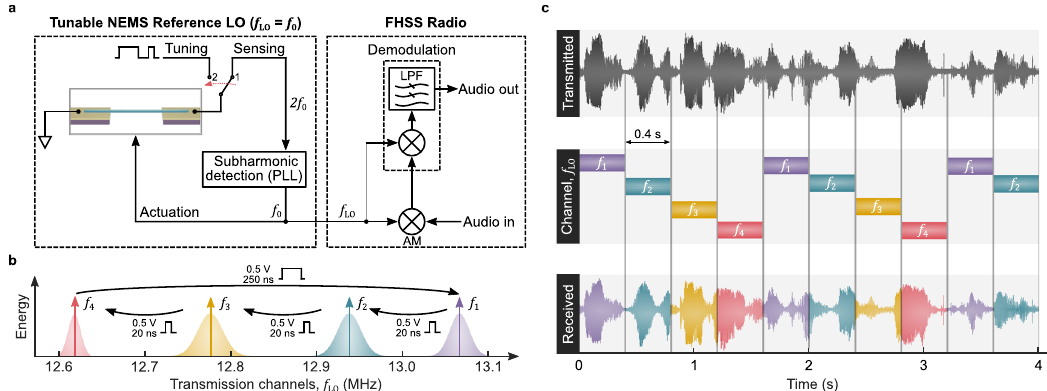
Fig. 5 Application idea for the phase-change NEMS resonator as a tunable local oscillator in FHSS systems and the corresponding experimental data. a Simpli fi ed block diagram of the FHSS radio transceiver exploiting the tunable NEMS resonator as an LO. Subharmonic detection in the LO loop compensates for the frequency doubling effect that stems from self-sensing piezoresistive detection. The RF switch isolates the tuning and electrical sensing circuitry. b Channel statistics for the frequency hopping sequence during multilevel operation. The channel frequency ( f LO ) was gradually decreased by sending 20 ns – 500 mV pulses into the nanowire and recovered via annealing pulses (250 ns – 500 mV), which resulted in the following frequency sequence: f 1 = 13.067 ± 0.011 MHz, f 2 = 12.938 ± 0.013 MHz, f 3 = 12.777± 0.014 MHz, and f 4 = 12.624 ± 0.006 MHz. c Transmitted and received audio segments of 4 s from Guglielmo Marconi ’ s speech in 1935, together with the real-time frequency hopping sequence (Supplementary Movie 1). Note that each channel is allocated to transmit for only 0.4